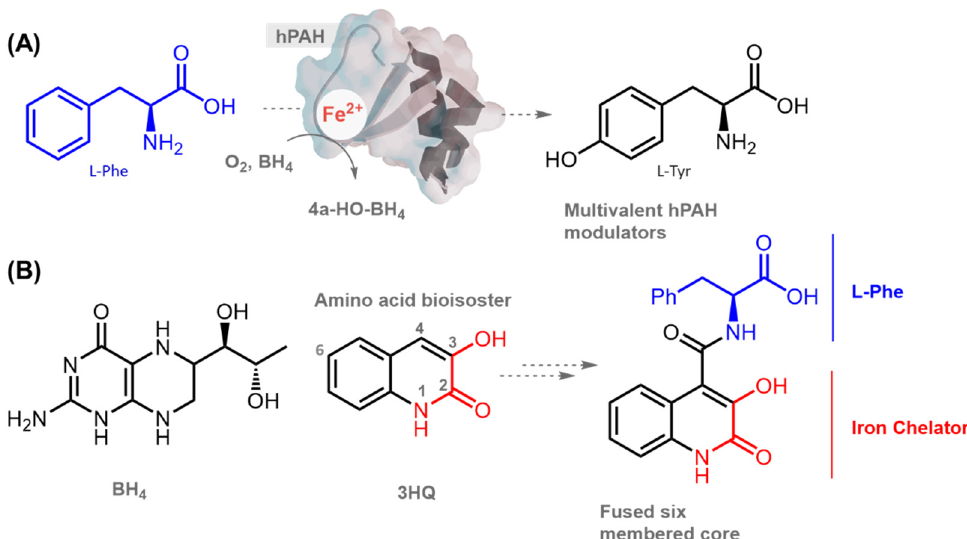
Figure 1. Rationale for the putative pharmacological/activity chaperone potential of 3-hydroxyquinolin-2(1H)-one (3HQ) derivatives towards human phenylalanine hydroxylase (hPAH). ( A ) Schematic representation of the reaction catalyzed by hPAH where L-phenylalanine ( L -Phe) is hydroxylated to L-tyrosine ( L -Tyr) in the presence of the cofactor (6R)-L-erythro-5,6,7,8-tetrahydrobiopterin (BH 4 ), Fe 2+ , and oxygen. ( B ) Structural properties of the 3HQs library, displaying structural similarities with BH 4 , presence of L -Phe at the 4-position and iron-coordinative proper- ties.